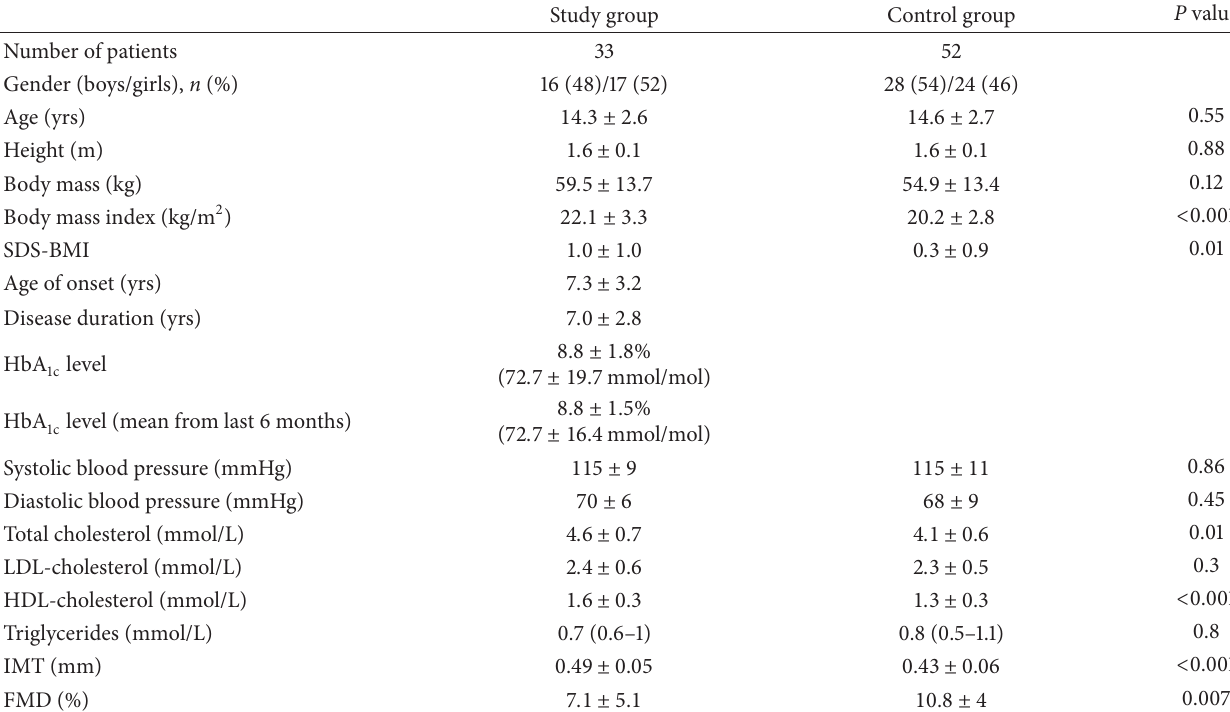
Table1:Generalcharacteristicsofstudygroups.Dataarepresentedasmean ± standarddeviationormedian(interquartilerange)fornormally and nonnormally distributed data,